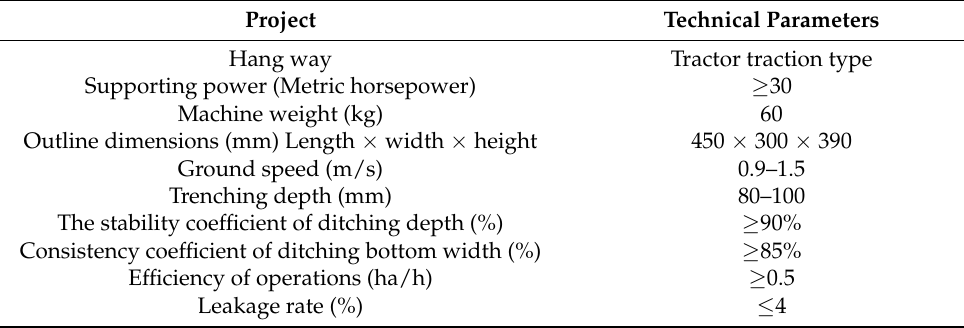
Table 1. The main technical parameters of the machines. Project Technical Parameters Hang way Tractor traction